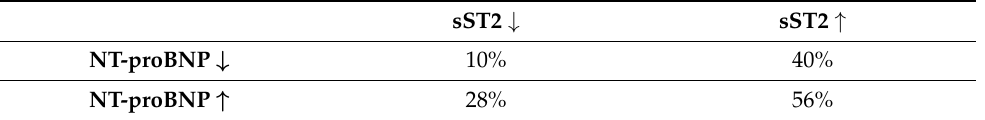
Table 2. Synergic effect of sST2 and NT-proBNP in the assessment of one-year mortality rates (%) in patients with heart failure (HF) (adapted from Rehman et al.) [61]. sST2 ↓ sST2 ↑ NT-proBNP ↓ 10% 40% NT-proBNP ↑ 28%